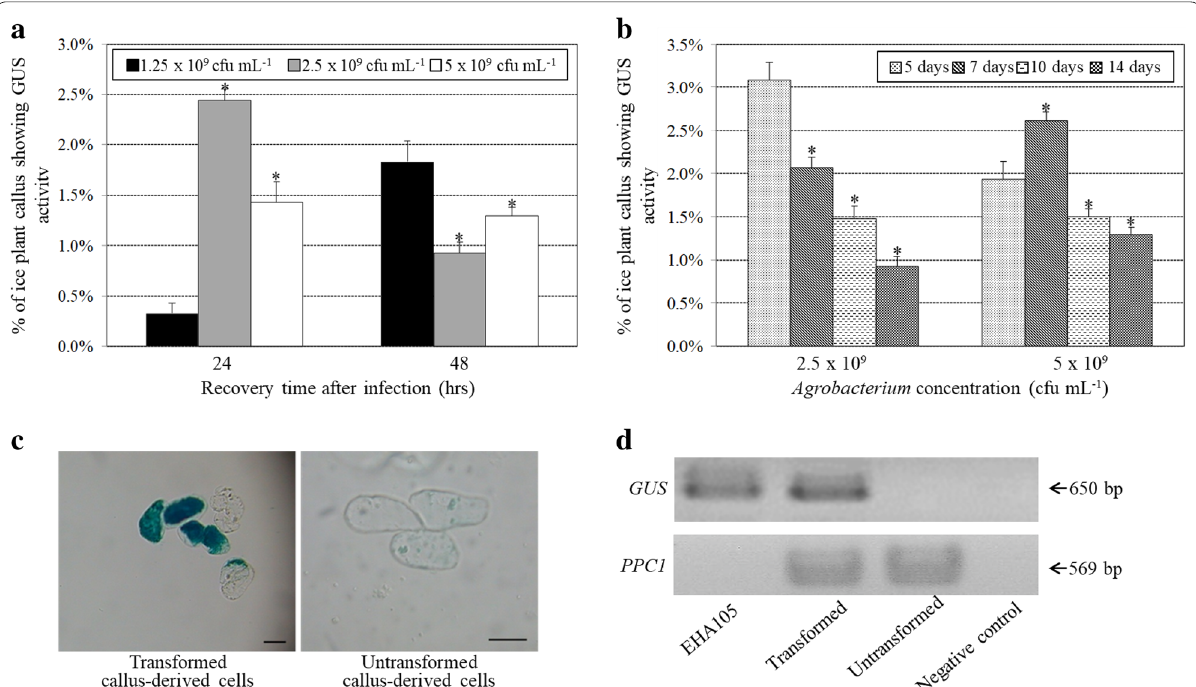
Fig. 1 The transient transformation efficiencies of ice plant callus after infection with Agrobacterium tumefaciens EHA105 strain harboring the pBISN1 binary vector. a Transformation rates of 14‑day‑old callus co‑incubated with 3 bacteria concentration solutions for 48 h and recovered for 24 or 48 h after infections. More than 2 10 5 callus‑derived cells were infected with A. tumefaciens strain for each independent transformation × assay. Data are mean SD from at least 3 independent experiments. *P < 0.05 comparing ice plant callus‑infected with 2.5 or 5 10 9 cfu mL − 1 ± × bacteria and callus‑infected with 1.25 10 9 cfu mL − 1 bacteria after same period of recovery time based on pairwise Student t ‑test. b × Transformation efficiency of callus collected on different days. Callus was co‑cultured with A. tumefaciens solutions for 48 h and recovered for 24 h after infection. *P < 0.05 comparing 7‑, 10‑, or 14‑day‑old infected callus and 5‑day‑old infected callus under the same bacteria concentration based on pairwise Student t ‑test. c Representative results of transformed ice plant callus‑derived cells (left panel) showing GUS staining and untransformed callus‑derived cells (right panel). Bar 50 μm. d Genomic DNA PCR results of the GUS reporter gene and the endogenous ice plant = phosphoenolpyruvate carboxylase ( PPC1 ) gene in 7‑day‑old transformed and untransformed callus. The arrow on the right indicates predicted band size. The A. tumefaciens EHA105 strain harboring pBISN1 was a positive control. Distilled water was a negative